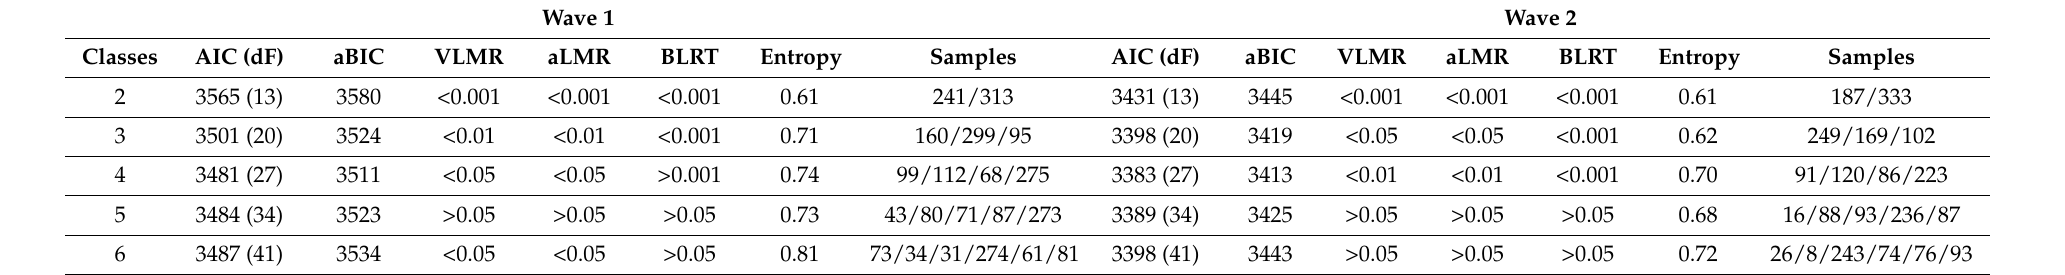
Table 4. Latent class analysis model fit statistics to select the number of classes of resilience at school for both waves sequentially. Wave 1 Wave